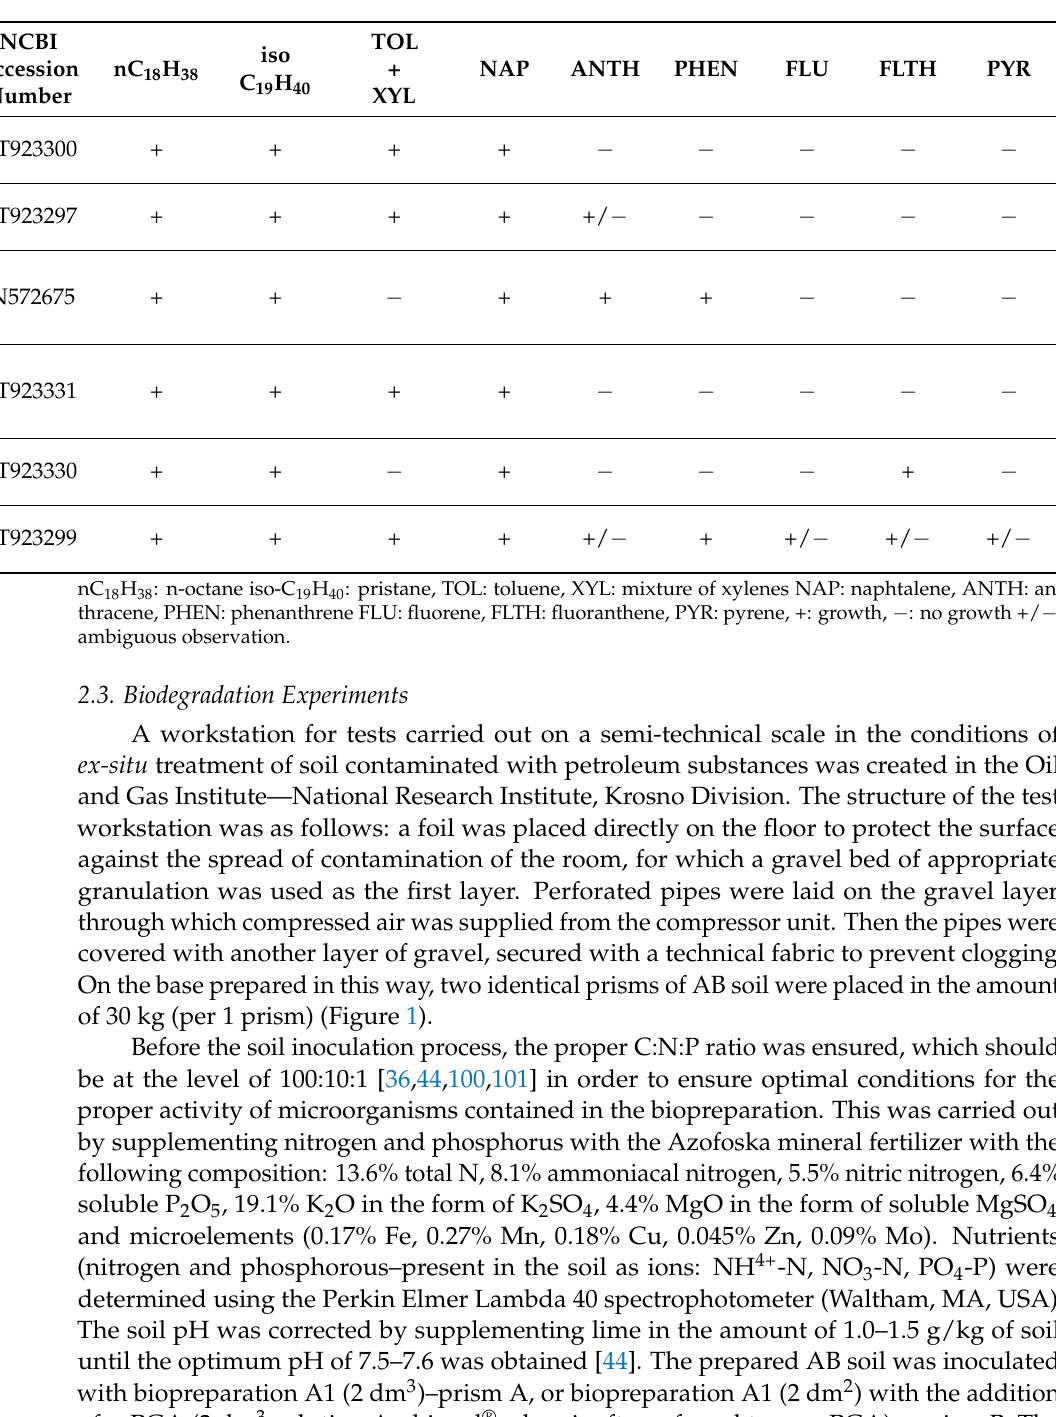
Table 2. Hydrocarbon-degrading capabilities of bacterial strains comprising the biopreparation